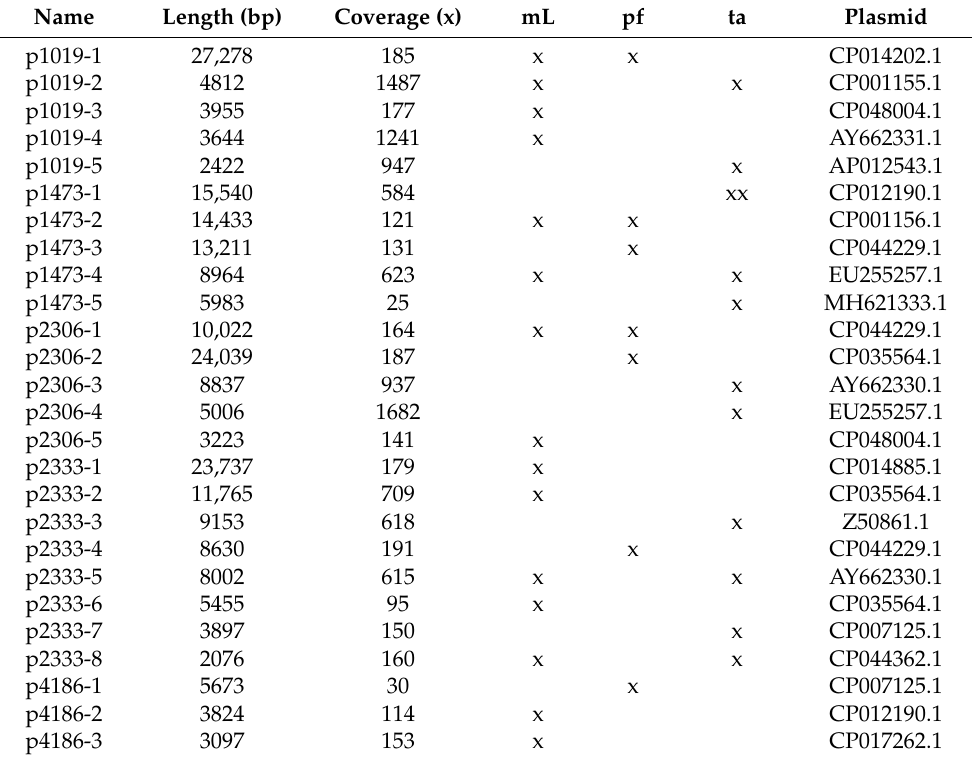
Table 2. Characteristics of the newly identified plasmid sequences. Plasmid names were assigned according to the Lacticaseibacillus strain the plasmid belongs to. Contig length and coverage are reported, as well as the identification criteria. mlplasmids software (mL), plasmid finder suite (pf), encoding type I toxin–antitoxin (TA) systems homologous to Lpt (ta), accession number of plasmids identified in the National Center for Biotechnology Information (NCBI) database with sequence identity above 95%